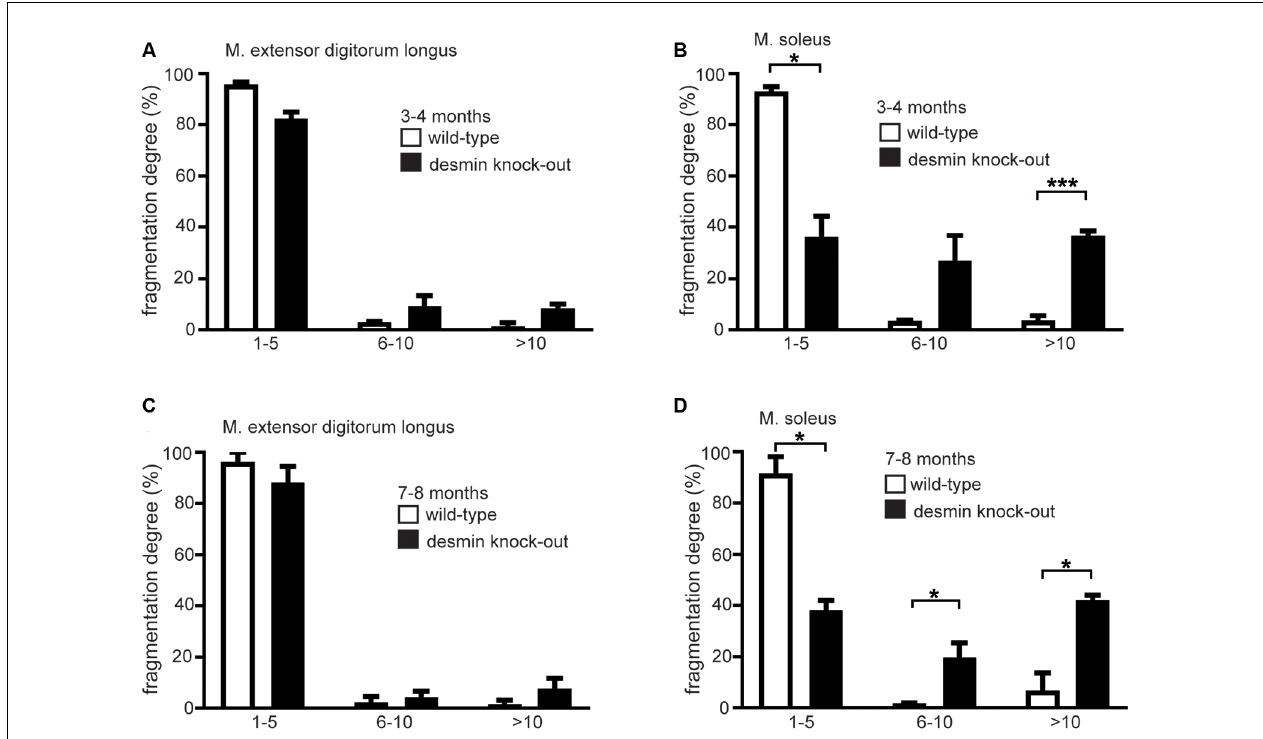
FIGURE 3 | The soleus muscle of desmin knock-out mice shows a higher degree of fragmentation of their NMJs. (A,B) The extensor digitorum longus or soleus muscle NMJs were categorized in groups according to their number of fragments. The number of NMJs in each group is given as the percentage of the total NMJ number for each genotype. For extensor digitorum longus a total of 96 wild-types and 89 homozygous, for soleus muscle 90 wild-type and 103 homozygous NMJs were counted ( n = 3 mouse pairs). Mice were 3–4 months old. Statistical significance was determined by unpaired two-tailed t -test (* P < 0.05, *** P < 0.001). (C,D) The extensor digitorum longus or soleus muscle NMJs were categorized in groups according to their number of fragments. The number of NMJs in each group is given as the percentage of the total NMJ number for each genotype. For extensor digitorum longus a total of 102 wild-types and 95 homozygous, for soleus muscle 99 wild-type and 102 homozygous NMJs were counted ( n = 3 mouse pairs). Mice were 7–8 months old. Statistical significance was determined by unpaired two-tailed t -test (* P <